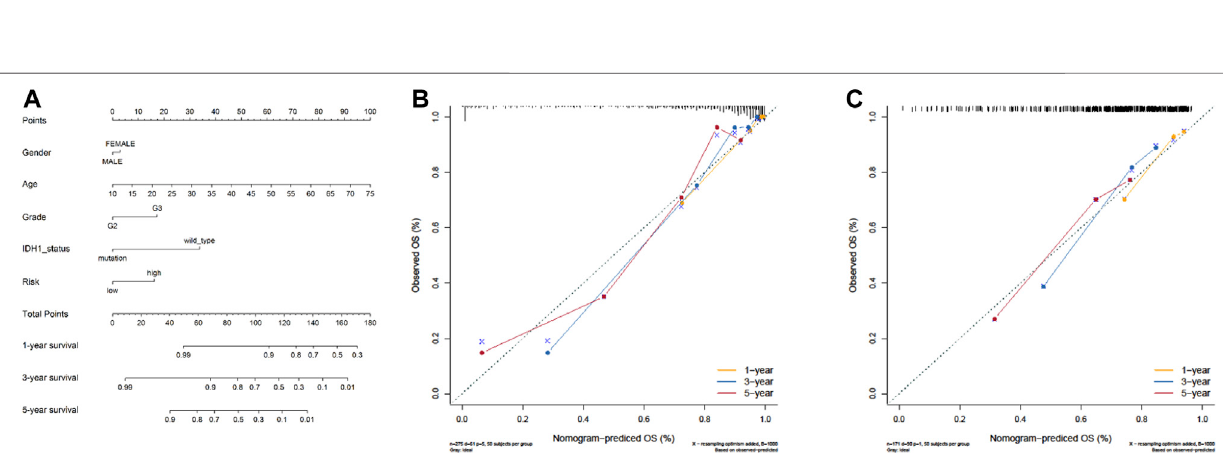
FIGURE 6 | The nomogram can predict the survival probability in LGG. (A) A nomogram of TCGA cohort used to predict the OS. (B, C) Calibration curves used to predict the one-, three-, and fi ve-year survival in TCGA derivation cohort and the CGGA validation cohort. The x-axis and y-axis represent the predicted and actual survival rates of the nomogram,